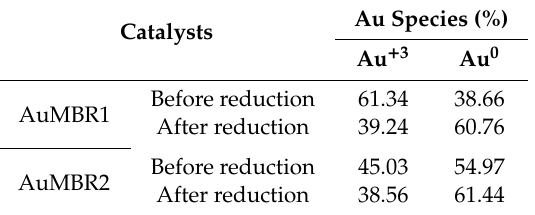
Figure 7. High-resolution XPS analysis of Au4f of ( a ) AuMBR1; ( b ) AuMBR1_R; ( c ) AuMBR2; and ( d ) AuMBR2_R (R: reduced). Table 2. Quantification of chemical gold species before and after reduction with H 2